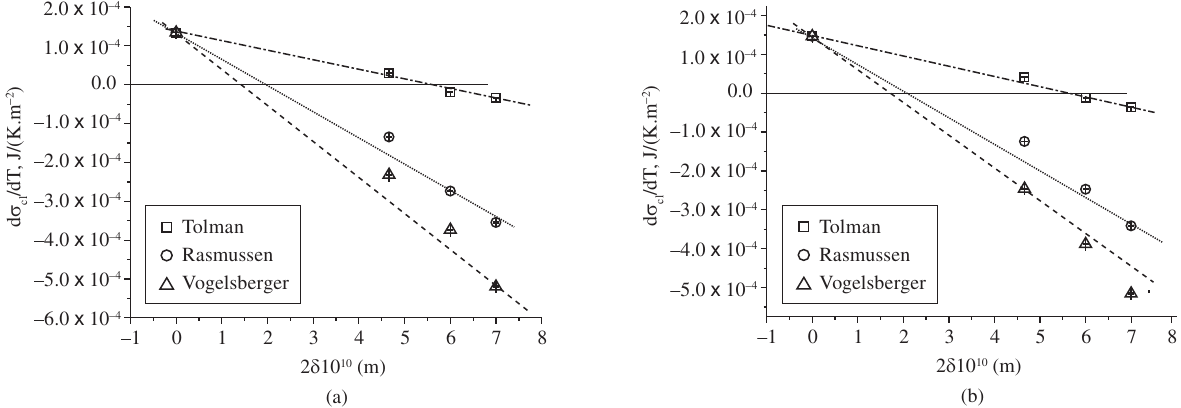
Figure 4. d σ /dT as function of δ for a LS glass using the Tolman, Rasmussen and Vogelsberger expressions, taking into account data of: a) viscosity, and b) cl 2 induction time.